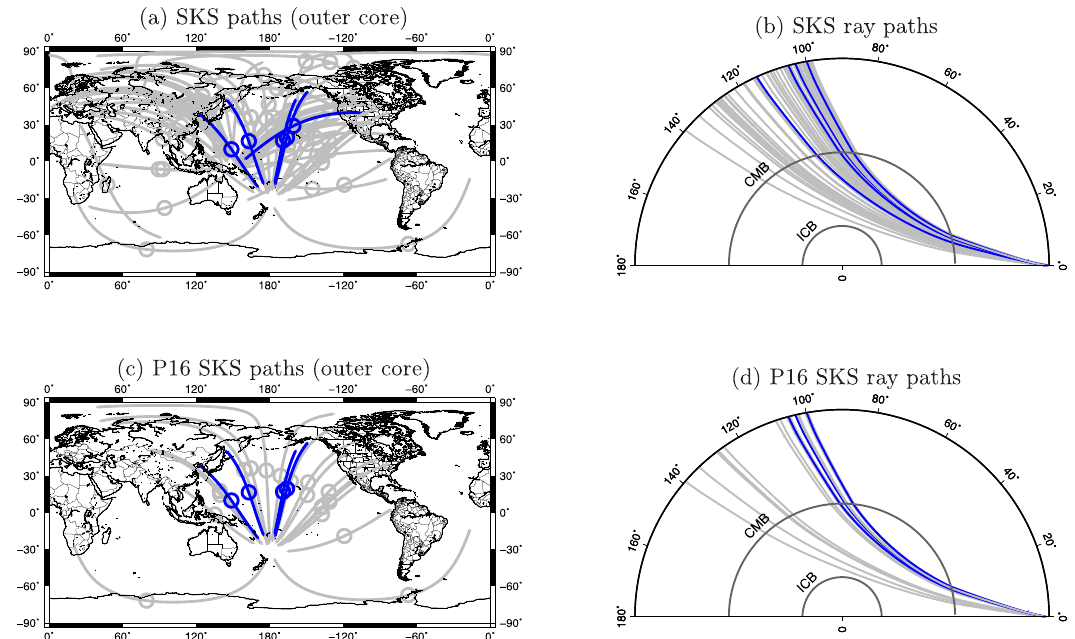
Fig. 4 SKS ray paths in map view and cross-section view. a SKS great-circle ray path segments in the outer core for the entire dataset. The circles indicate the turning points of the SKS waves. The blue paths are the anomalous SKS waves that can not be explained by possible earthquake mislocations. The cross-section view of the SKS paths are plotted in ( b ), the anomalous SKS paths all turn in the upper half of the outer core. c , d are the same as ( a ) and ( b ) but for earthquake pair P16. CMB Core-Mantle boundary, ICB inner core boundary.